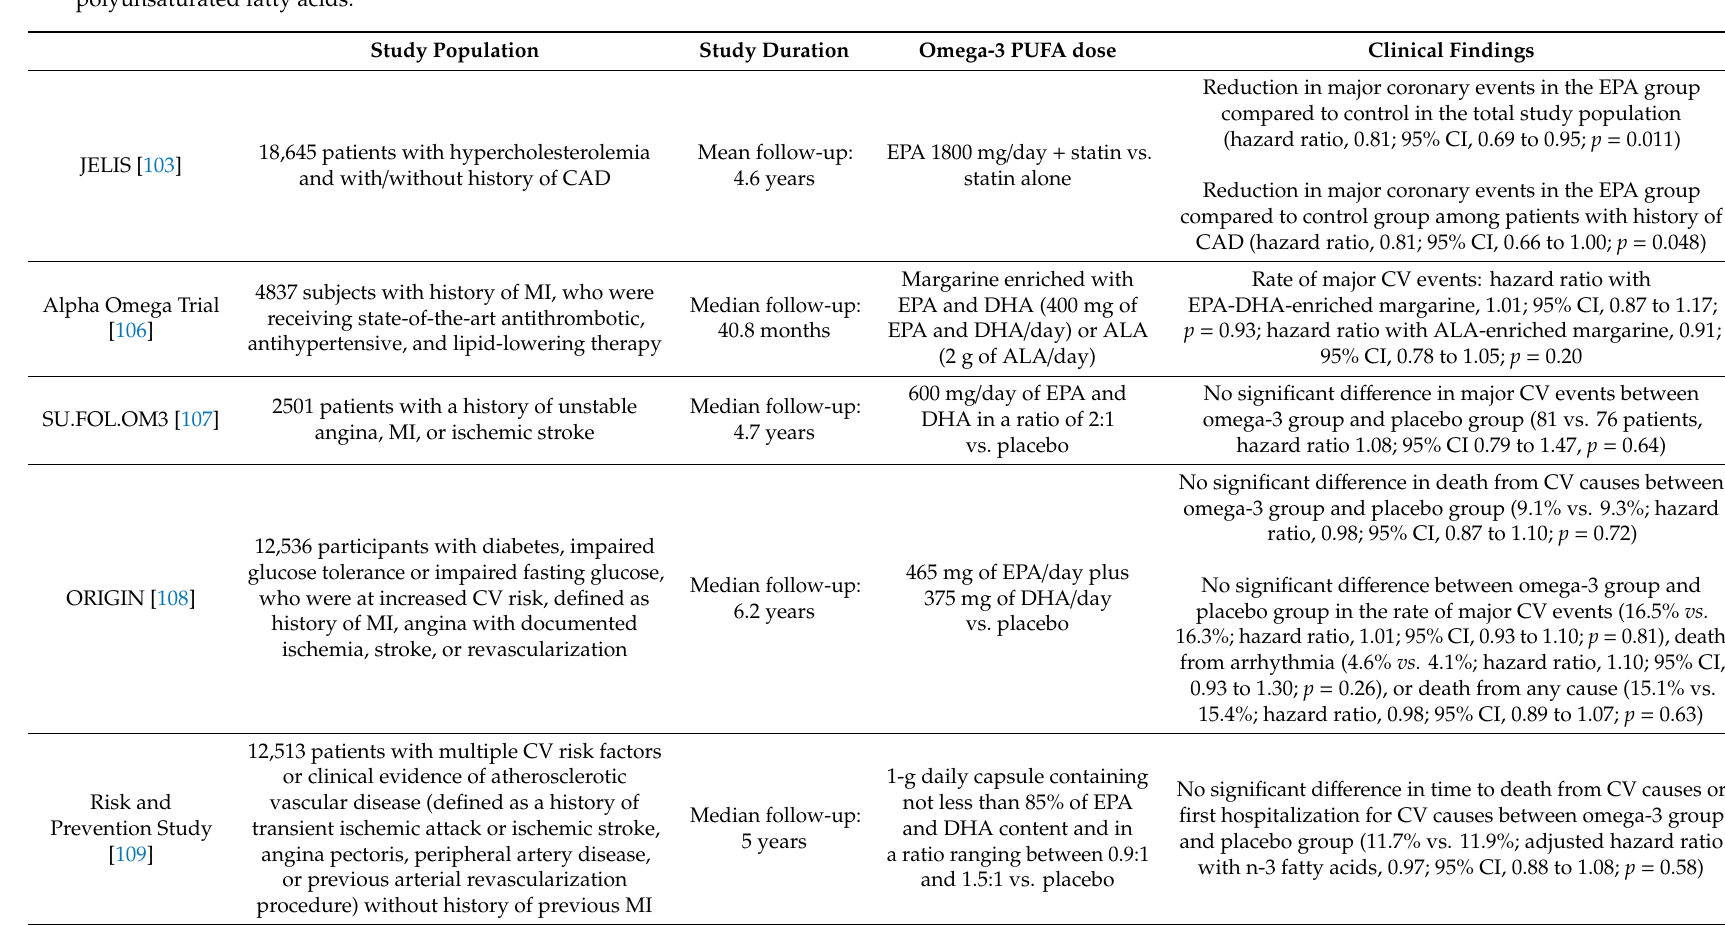
Table 1. Summary of the main randomized controlled trials assessing the e ffi cacy of omega-3 PUFAs in primary and secondary prevention of cardiovascular disease and vascular cognitive impairment and dementia. Abbreviations: ALA, alpha-linolenic acid; CAD, coronary artery disease; CI, confidence interval; CV, cardiovascular; CVD, cardiovascular disease; EPA, eicosapentaenoic acid; DHA, docosahexaenoic acid; hsCRP, high-sensitivity C-reactive protein; MI, myocardial infarction; PUFA, polyunsaturated fatty